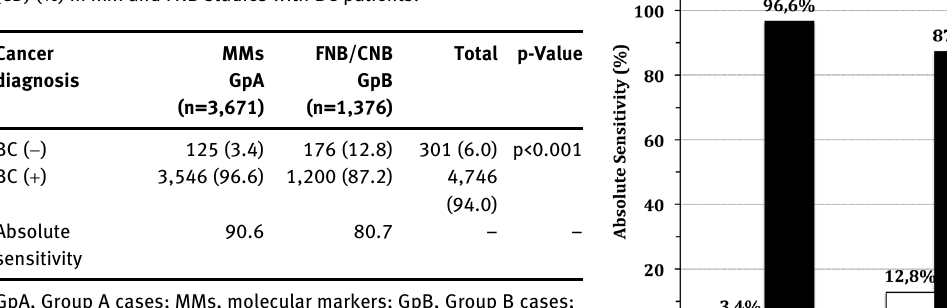
Table  : Absolute sensitivities (%), mis- (MD) and correct diagnosis (CD) (%) in MM and FNB studies with BC patients.